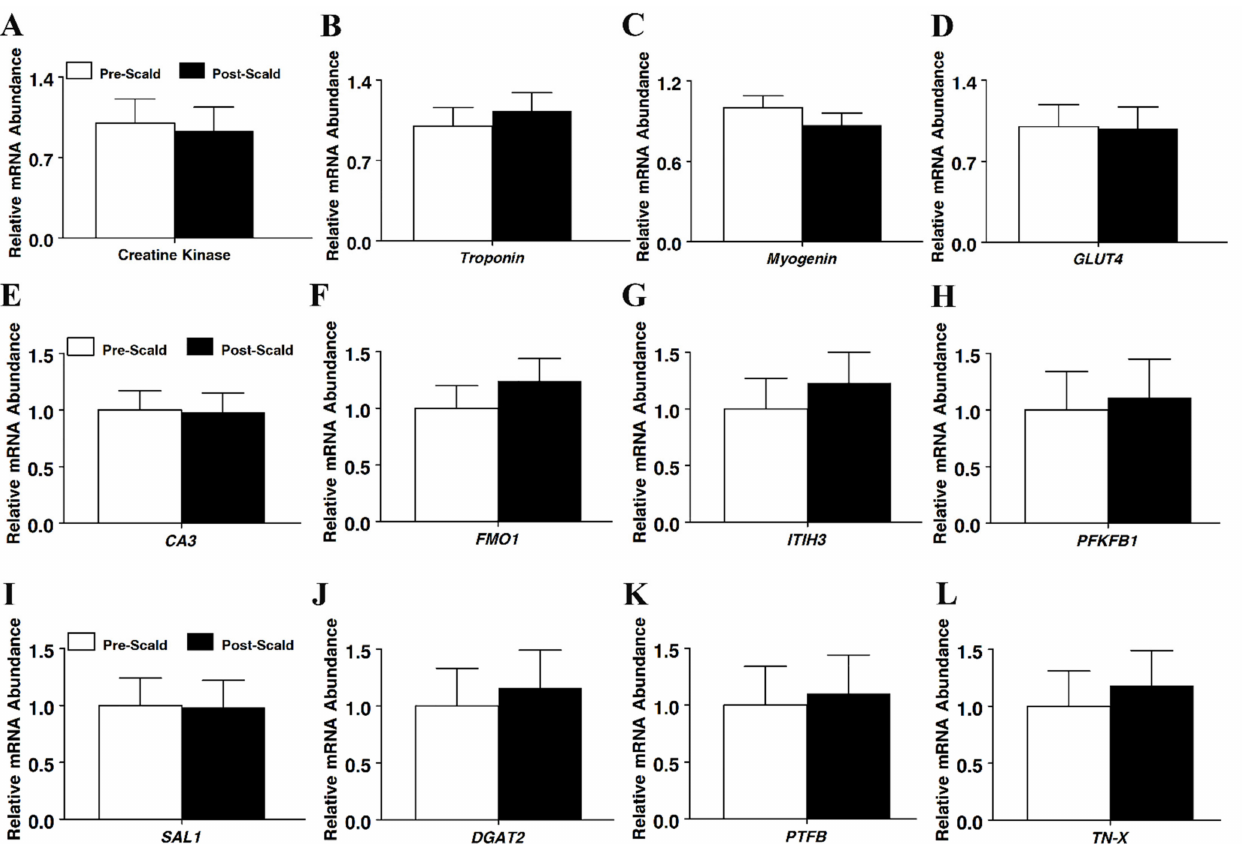
Figure 3. The effect of scalding on mRNA expression in the longissimus dorsi muscle of market weight hogs, as measured using real-time RT-PCR for genes ( A ) creatine kinase, ( B ) troponin, ( C ) myo- genin, ( D ) glucose transporter 4 ( GLUT4 ), ( E ) carbonic anhydrase III ( CA3 ), ( F ) flavin-containing monooxygenase 1 ( FMO1 ), ( G ) inter-alpha (globulin) inhibitor H3 ( ITIH3 ), ( H ) 6-phosphofructo- 2-kinase/fructose-2,6-biphosphatase 1 ( PFKFB1 ), ( I ) salivary lipocalin ( SAL1 ) , ( J ) diacylglycerol O-acyltransferase 2 ( DGAT2 ), ( K ) pleiotropic factor beta ( PTF β ), and ( L ) tenascin-X ( TN-X ). Values were normalized to S15 expression. Data are normalized to S15 mRNA abundance and expressed as a fold change relative to pre-scald samples and calculated according to Pfaffl (2010). Bars denoted by differ ( p < 0.05); pre-scald, n = 8; post-scald, n =